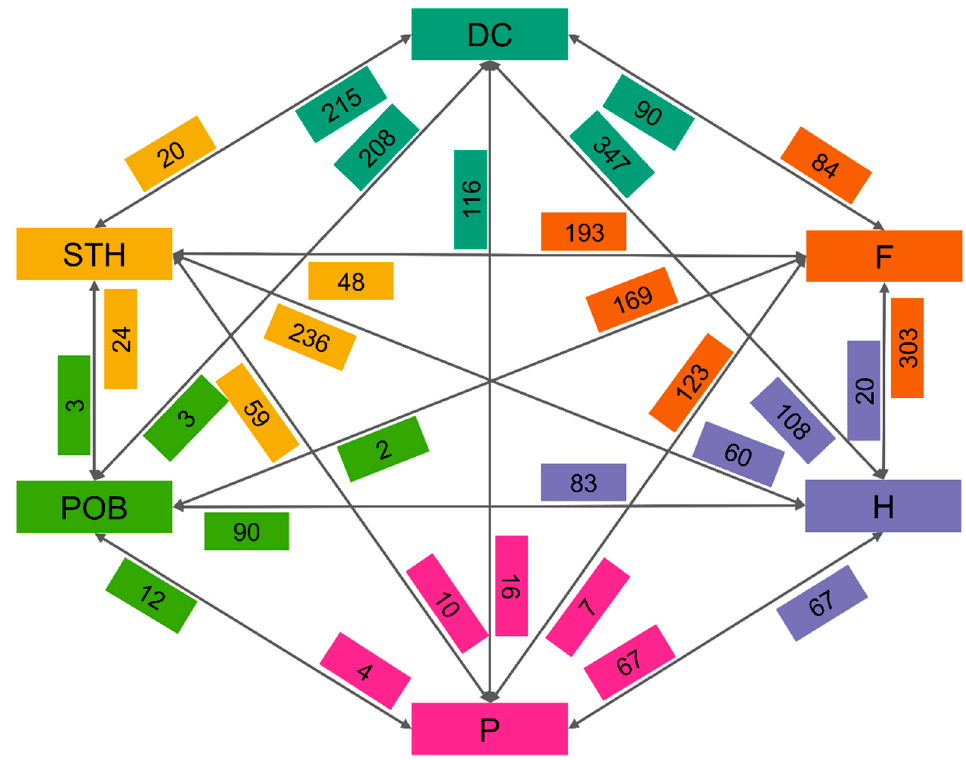
Figure 7. Summary of changes in the number of unique alleles during more than 120 years of breed- ing and cultivation of oats in Poland. Colors indicate groups, and arrows connect compared